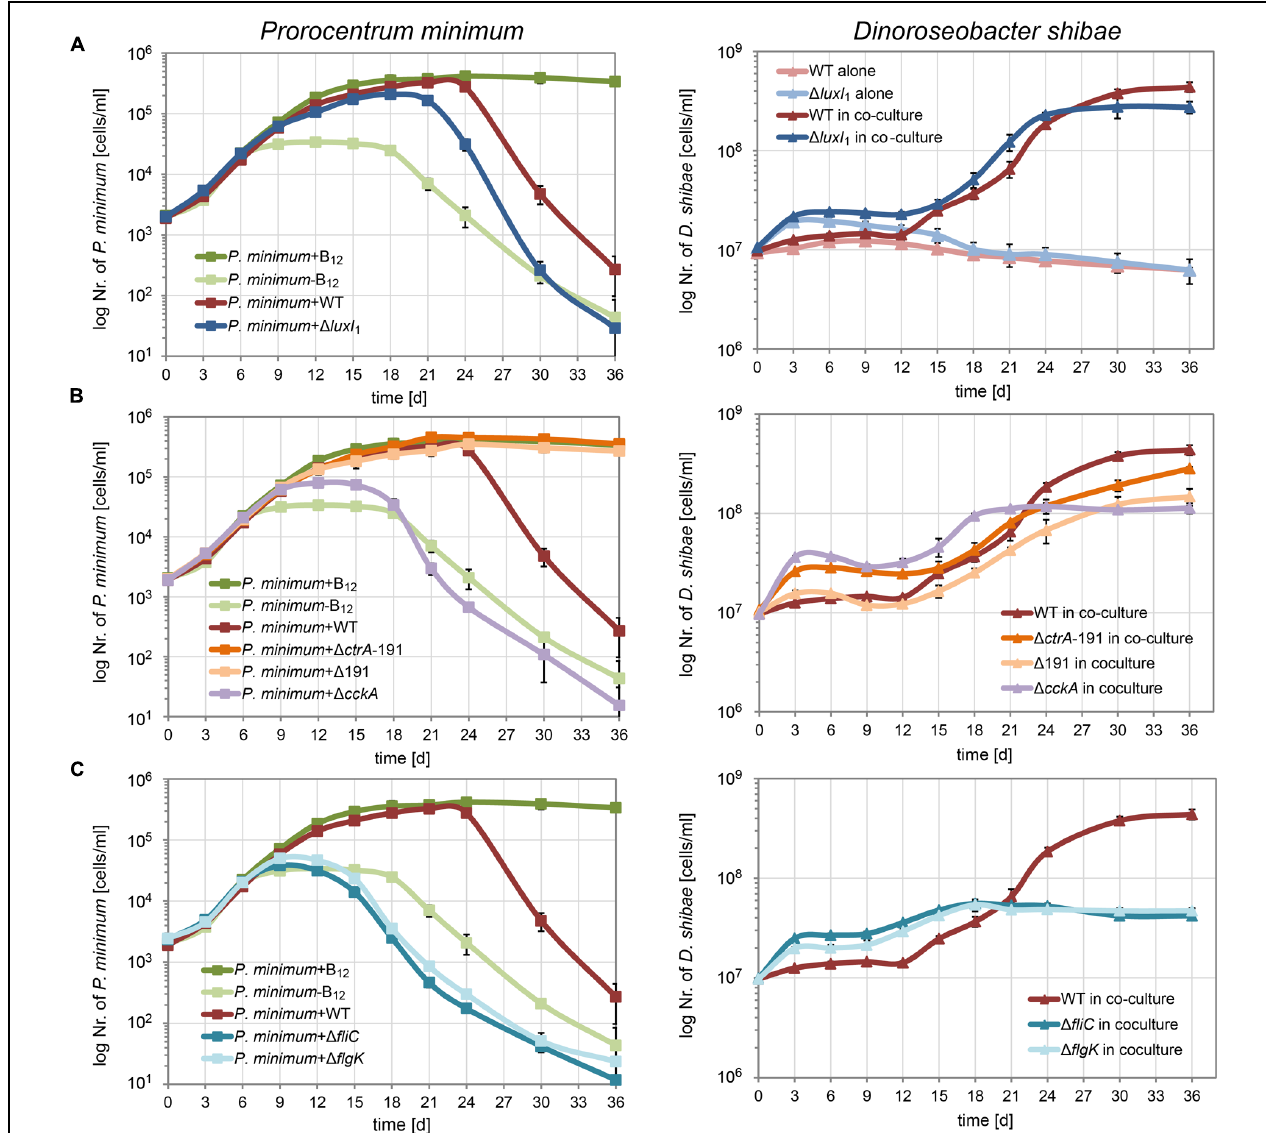
FIGURE 3 | Growth of P. minimum and different D. shibae mutants in co-culture. P. minimum cell numbers are shown on the left, D. shibae cell numbers are shown on the right. The P. minimum positive and negative controls as well as the growth of the co-culture with wild-type D. shibae are shown in every panel for comparison. (A) Co-culture with the quorum sensing null-mutant D. shibae (cid:2) luxI 1 , (B) with the phosphorelay knock-out mutants D. shibae (cid:2) cckA and (cid:2) ctrA -191, the latter additionally lacking the 191 kb plasmid, and a (cid:2) 191 kb cured mutant with intact ctrA gene, (C) with D. shibae (cid:2) fliC and (cid:2) flik , lacking functional flagella. Data represent mean and standard deviation of three biological